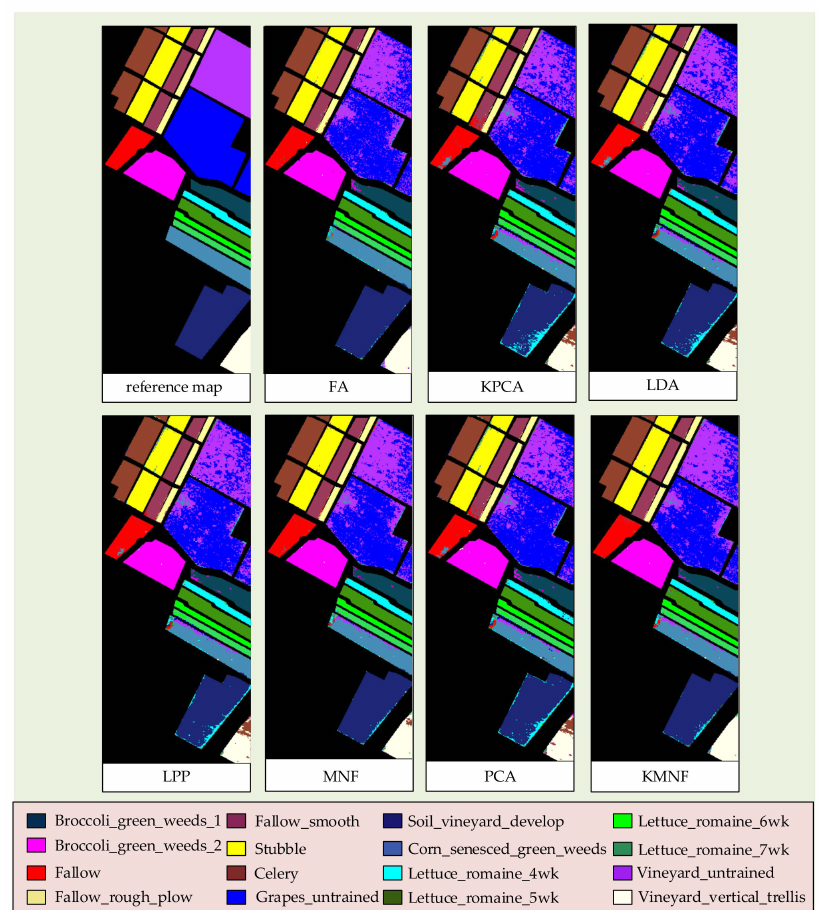
Figure 6. The results of SVM classifier for Salinas after each feature extraction method (number of features =